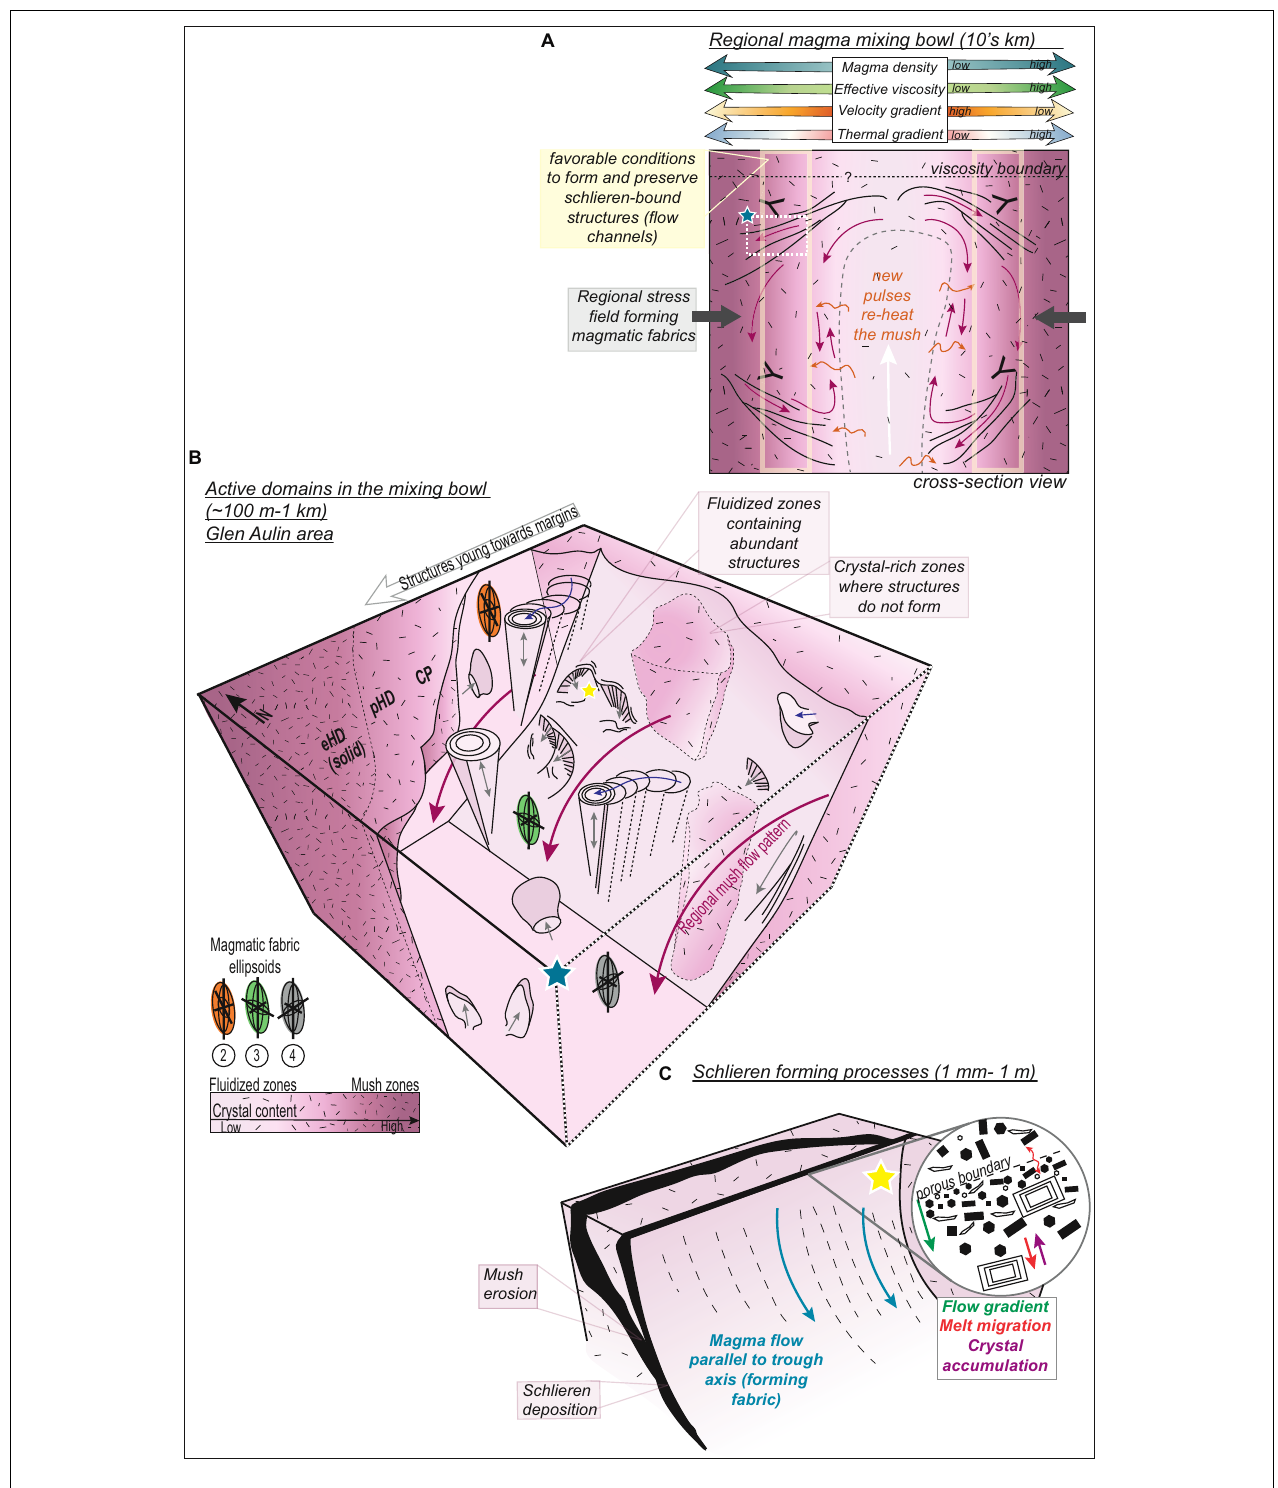
FIGURE 12 | Summary of multi-scale dynamic processes operating in mobile magma mushes. (A) Mixing bowl scale. Return flow of the mush is triggered by intruding pulses in the center of the complex. Thermal/mechanical gradients aid convection. (B) Domain scale activity summarized as a 3D diagram. Structures form in fluidized zones that are more melt-rich due to local changes in pore-pressure, viscosity, and stress, while crystal rich zones represent zones that are absent of schlieren-bound structures. They still contain melt as they contain magmatic fabrics, dikes and other structure. (C) Structure-scale processes demonstrated for a magmatic trough. Flow sorting, filter pressing, crystal accumulation and melt escape are all important processes at the mm-cm scale. Flow along the trough channel produces a lineation in hornblende.